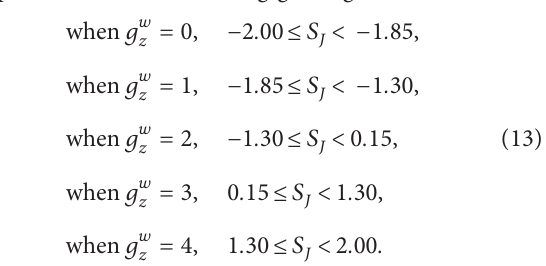
Table 2 can be adopted as natural convention of 5-soft set